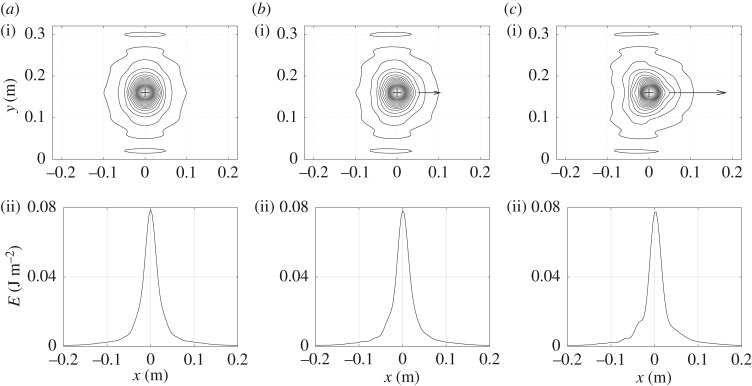
Repartition of Lagrangian vibrational energy E∂ near the moving point force at f = 2000 Hz for various moving speeds. Isovalues of energy (i) and energy versus position along the horizontal line y = 0.16 (ii): (a) V = 0 km h−1, (b) V = 90 km h−1 and (c) V = 216 km h−1.